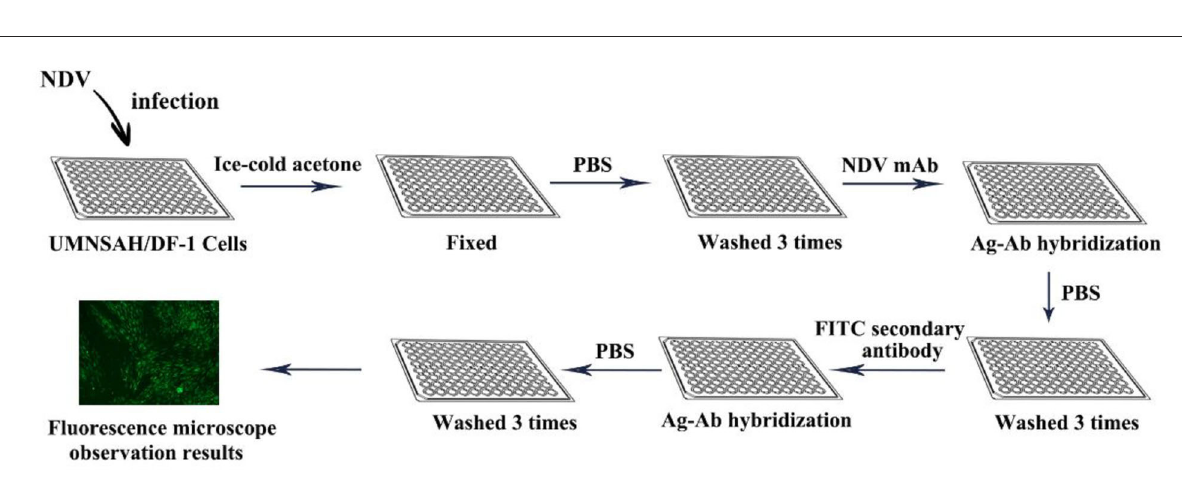
FIGURE7 Schematic illustration of indirect immunofluorescence of